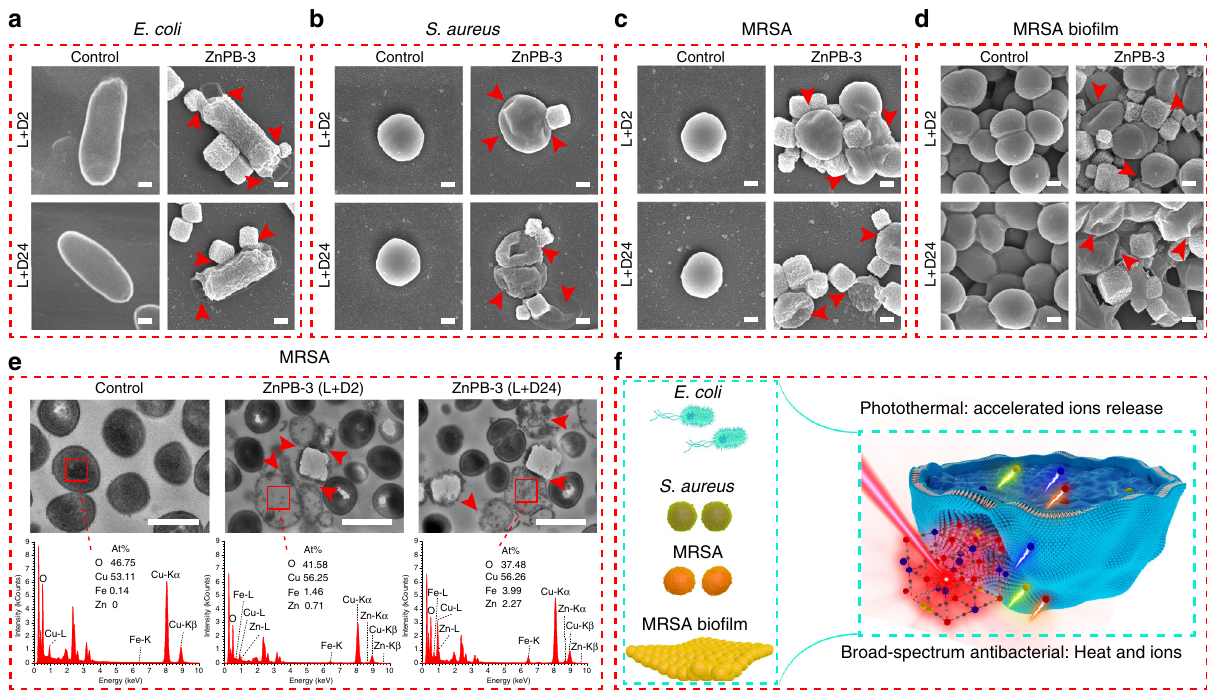
Fig. 6 Antibacterial mechanism. SEM morphologies of bacteria, including a E. coli , b S. aureus , c MRSA and d MRSA bio fi lm, interacted with ZnPB-3 for L + D2 and L + D24 groups (scale bars = 200 nm). e TEM images of ultrathin section and corresponding EDS of MRSA treated with ZnPB-3 (scale bars = 1 μ m). f Antibacterial mechanism of optimized synergistic effect of heat and ion release. Red arrows show severe damage and obvious cytoplasm leakage of bacteria. Source data are provided as a Source Data fi